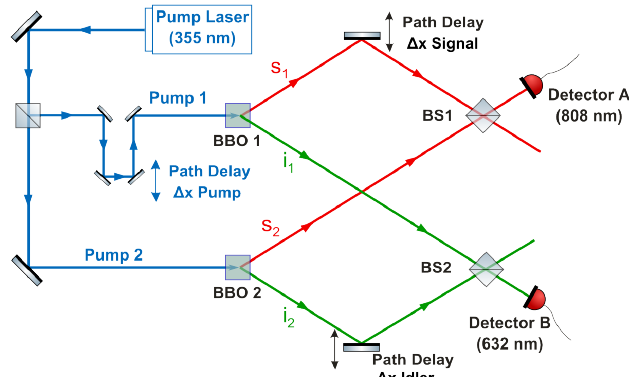
Figure 1. Two-photon interference setup with two synchronously-pumped spontaneous parametric down-conversion (SPDC) crystals BBO1 and BBO2. The rate of counting signal and idler photons in coincidence at Detectors A and B is measured as a function of the path delay of the pump field. The pump intensity is sufficiently weak such that with high probability, only one signal-idler photon pair is present during a measuring period. BS, beam splitter.